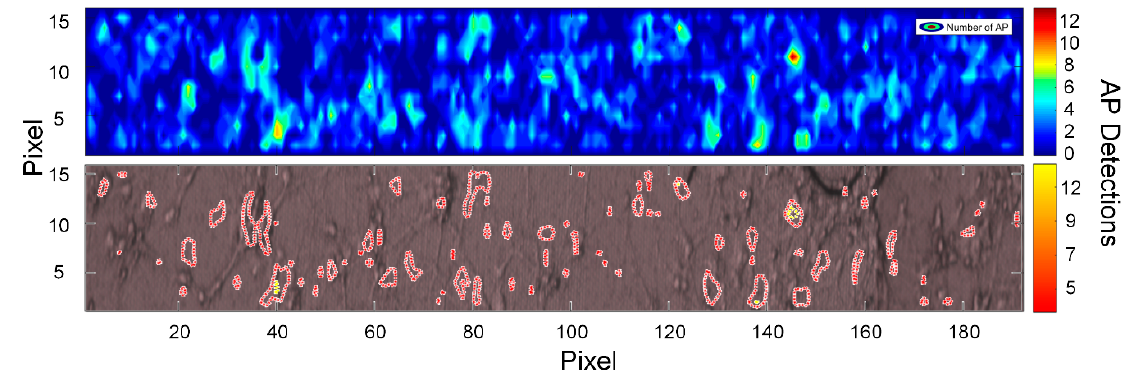
Figure 16. Neural spike (action potential) spatial map (over 15 s acquisition time).